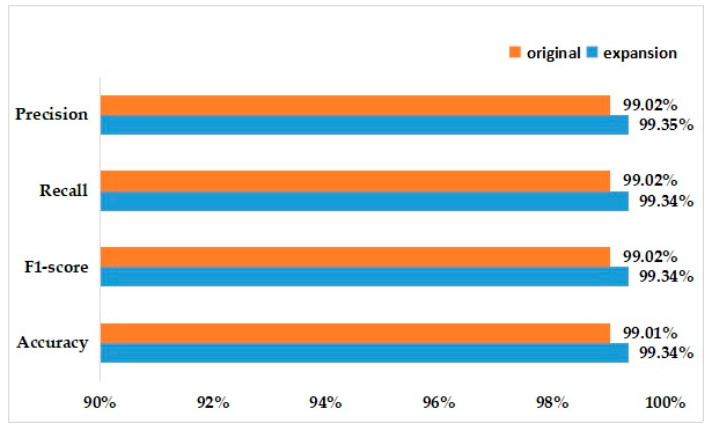
Figure 12. Recognition accuracy for the initial and expanded data.